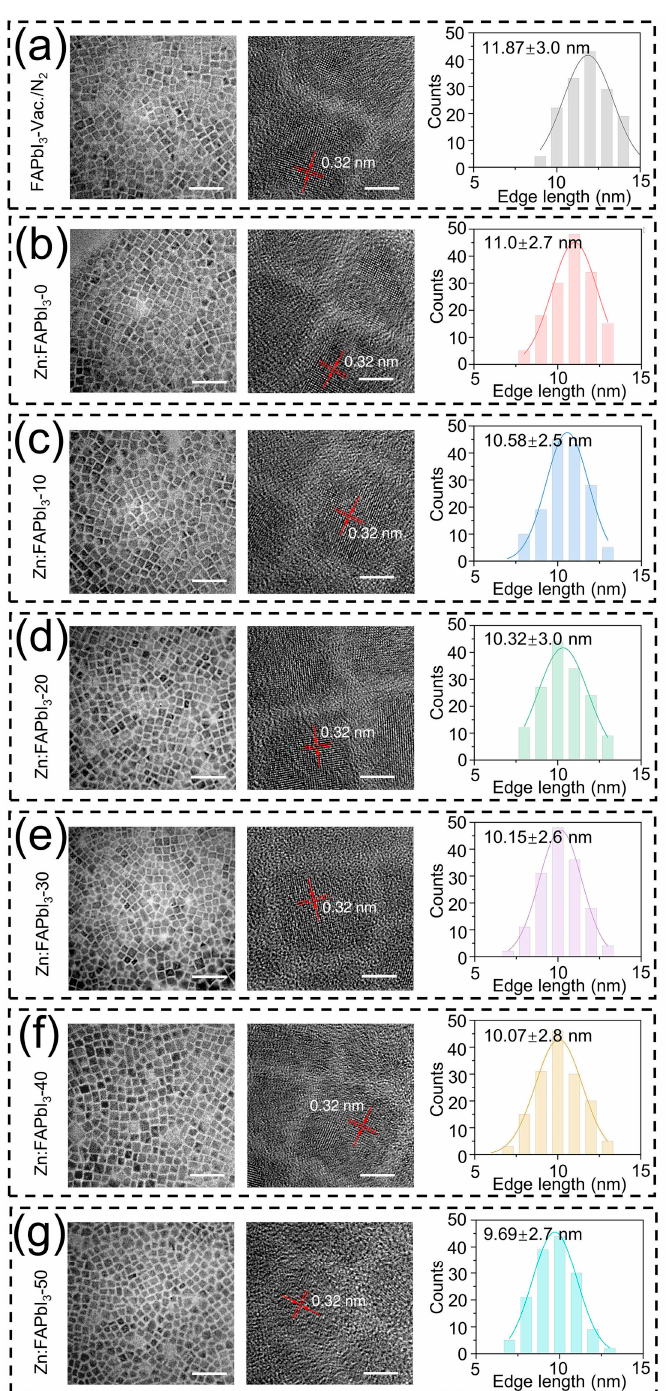
Figure 2. TEM images and size distributions with Gauss fitting of FAPbI 3 -vaccum/N 2 ( a ), Zn:FAPbI 3 - 0 ( b ), Zn:FAPbI 3 -10 ( c ), Zn:FAPbI 3 -20 ( d ), Zn:FAPbI 3 -30 ( e ), Zn:FAPbI 3 -40 ( f ), and Zn:FAPbI 3 -50 ( g ) PQDs. The scale bars in the left and right TEM images are 50 nm and 5 nm, respectively. The size distributions are obtained by counting 150 particles.